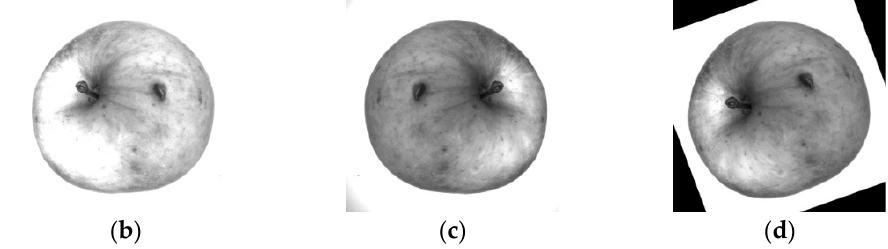
Figure 4. The original image and its schematic of data enhancement. ( a ) The original image ( b ) brightness enhancement ( c ) flip ( d ) angle rotation.